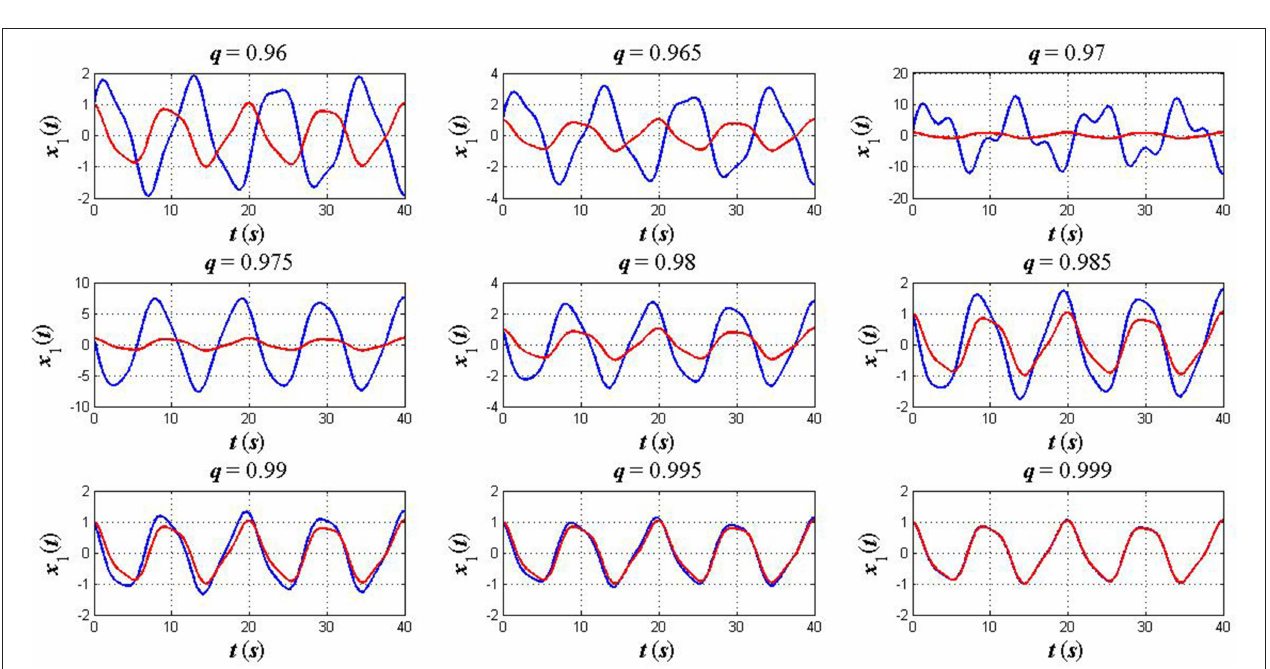
FIGURE 4 | The plots of x 1 ( t ) in the fractional sense (blue) and classical sense (red): an anti–symmetric initial position x 1 (0) = x 2 (0) = 1.